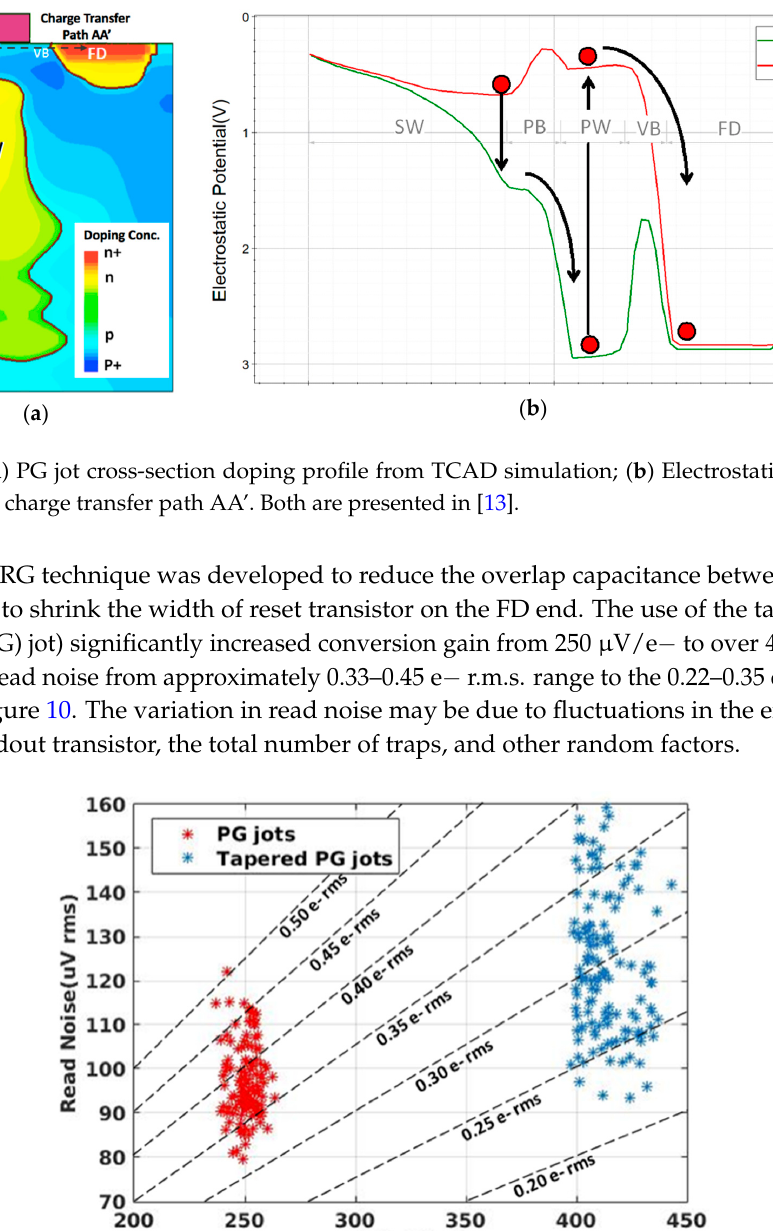
Figure 10. Scatter plot of voltage read noise vs. CG for PG jots and TPG jots. The read noise in e − r.m.s. levels are shown with dashed lines. Presented in [18].